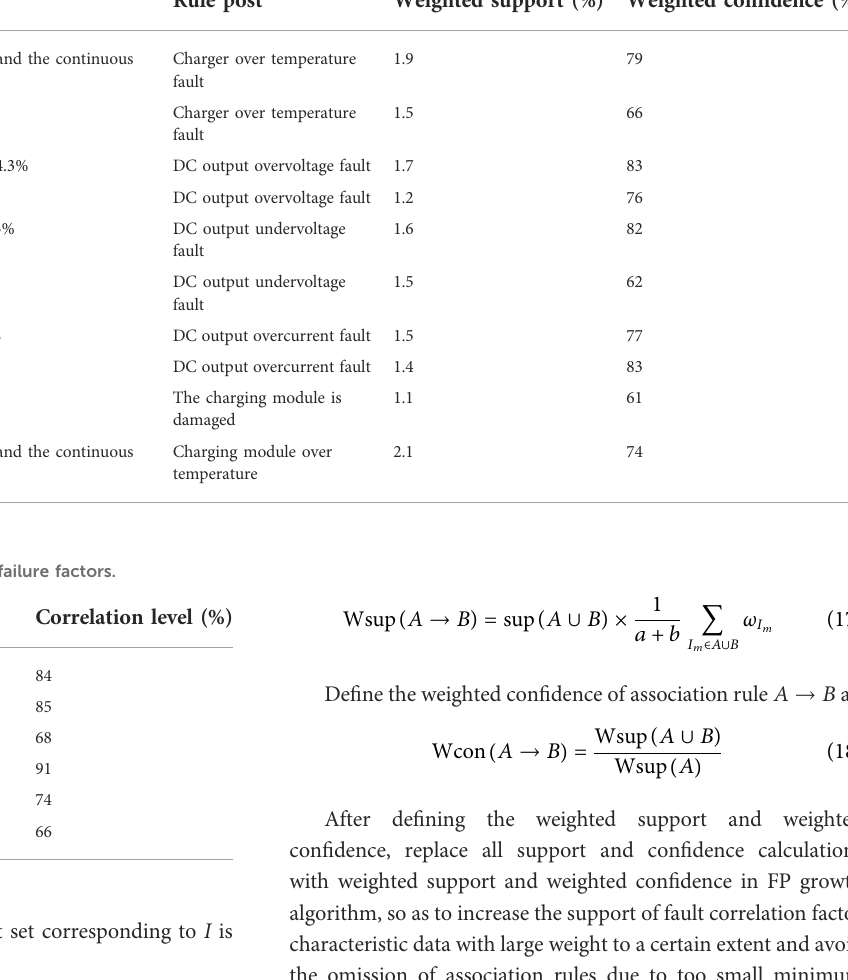
TABLE 8 DC charger fault association rules.